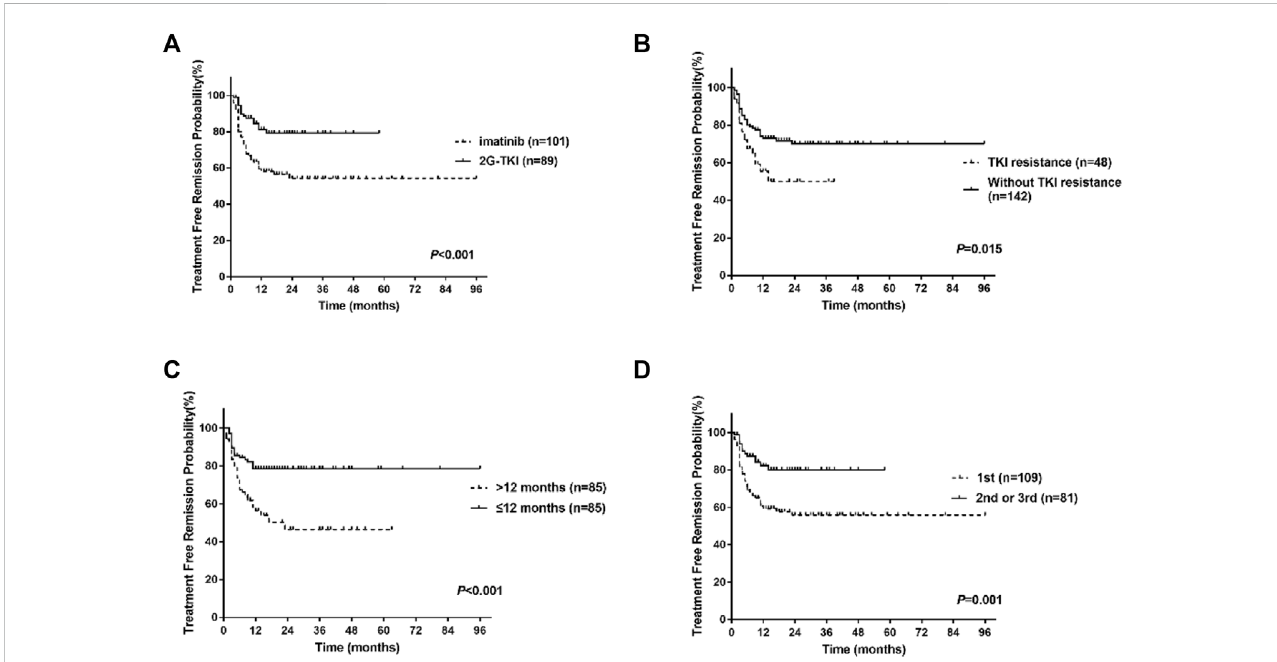
FIGURE 3 Treatment-free remission (TFR) after tyrosine kinase inhibitor (TKI) therapy. (A) TFR in patients according to the type of TKI at discontinuation. (B) TFR in patients according to TKI resistance. (C) TFR in patients according to the time to MR4. (D) TFR in patients according to the line of TKI. 2G-TKI, second- generation TKI.